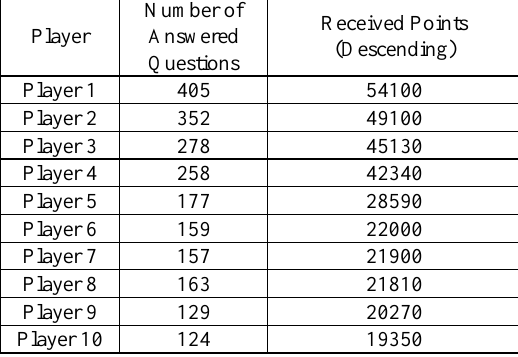
Table 2. Top ten players based on received